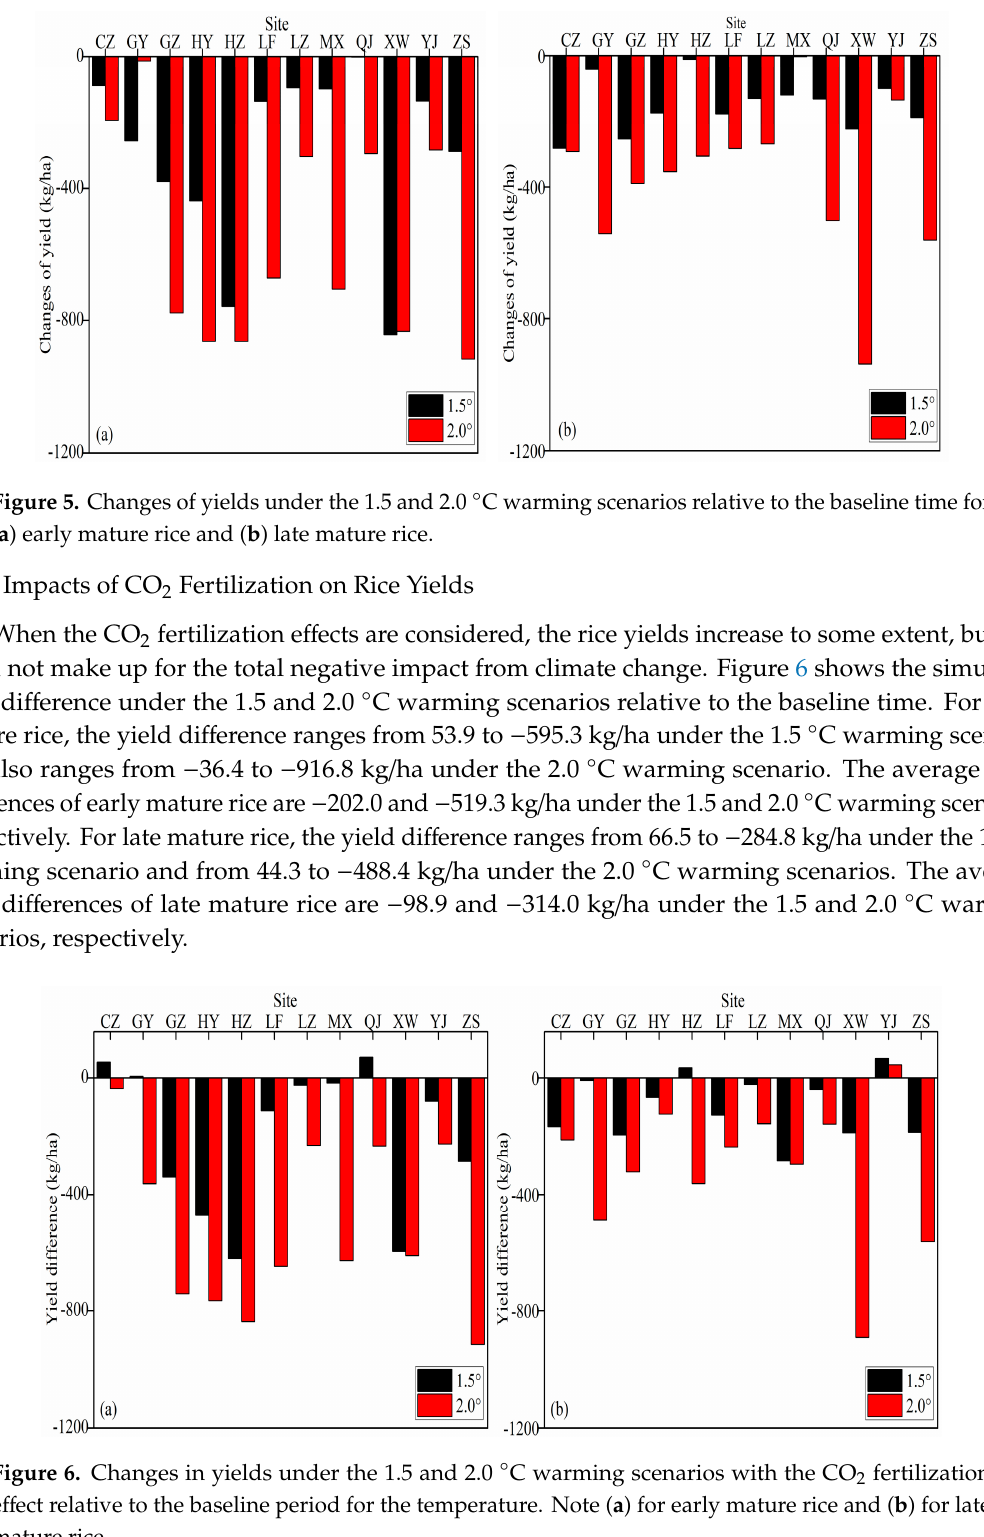
Table 3. The relationship between climatic variables and rice yields.